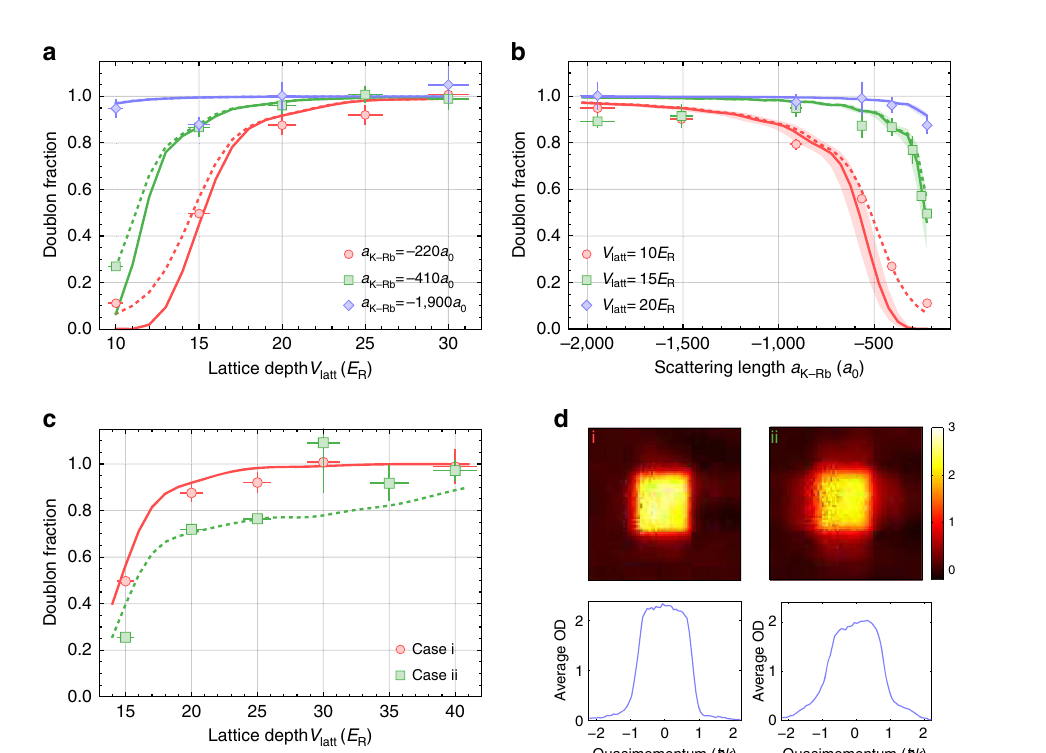
Figure 3 | Interaction and tunnelling dynamics of doublons in the lattice. ( a ) The remaining doublon fraction is shown for three scattering lengths as a function of the lattice depth. ( b ) The doublon fraction is plotted for three lattice depths as a function of the scattering length. ( c ) The doublon fraction for 1.68mTms (cid:2) 1 sweeps, t ¼ 1ms and a K-Rb ¼ (cid:2) 220 a 0 is shown as a function of the lattice depth for the case of higher excited-band fraction (squares) and lower excited-band fraction (circles). ( d ) Band-mapping images of the initial K gas are shown for the two different initial temperatures, where image i corresponds to the red circle data points and ii corresponds to the green square data points in ( c ). Each image is the average of three measurements. The colour bar indicates the optical depth (OD). Below the images, we display the OD for a horizontal trace through the image, with averaging from (cid:2) : k to þ : k in the vertical direction. All error bars represent 1 (cid:2) s standard